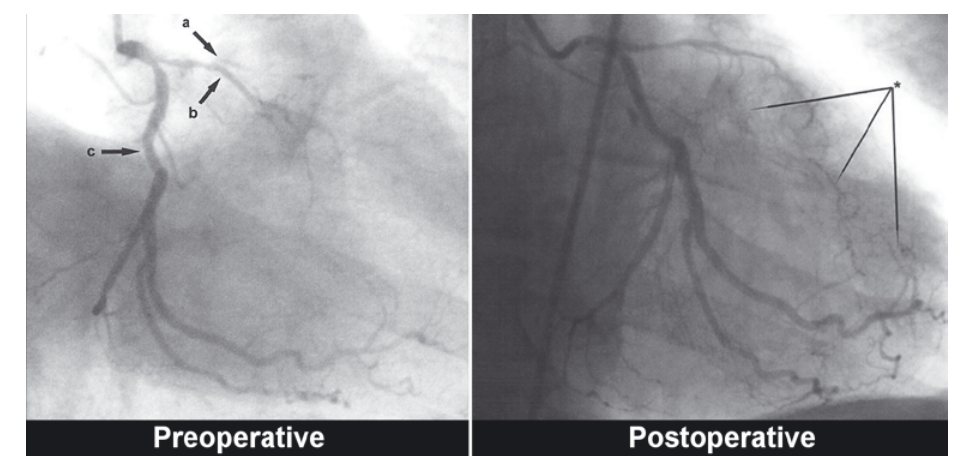
Figure 1. Preoperative and postoperative (month 12) angiographies. a. Total occlusion in left anterior descending (LAD) coronary artery with inadequate distal filling. b. Thin diagonal artery. c. Dominant and normal circumflex coronary artery. *Newly developed widespread collateral